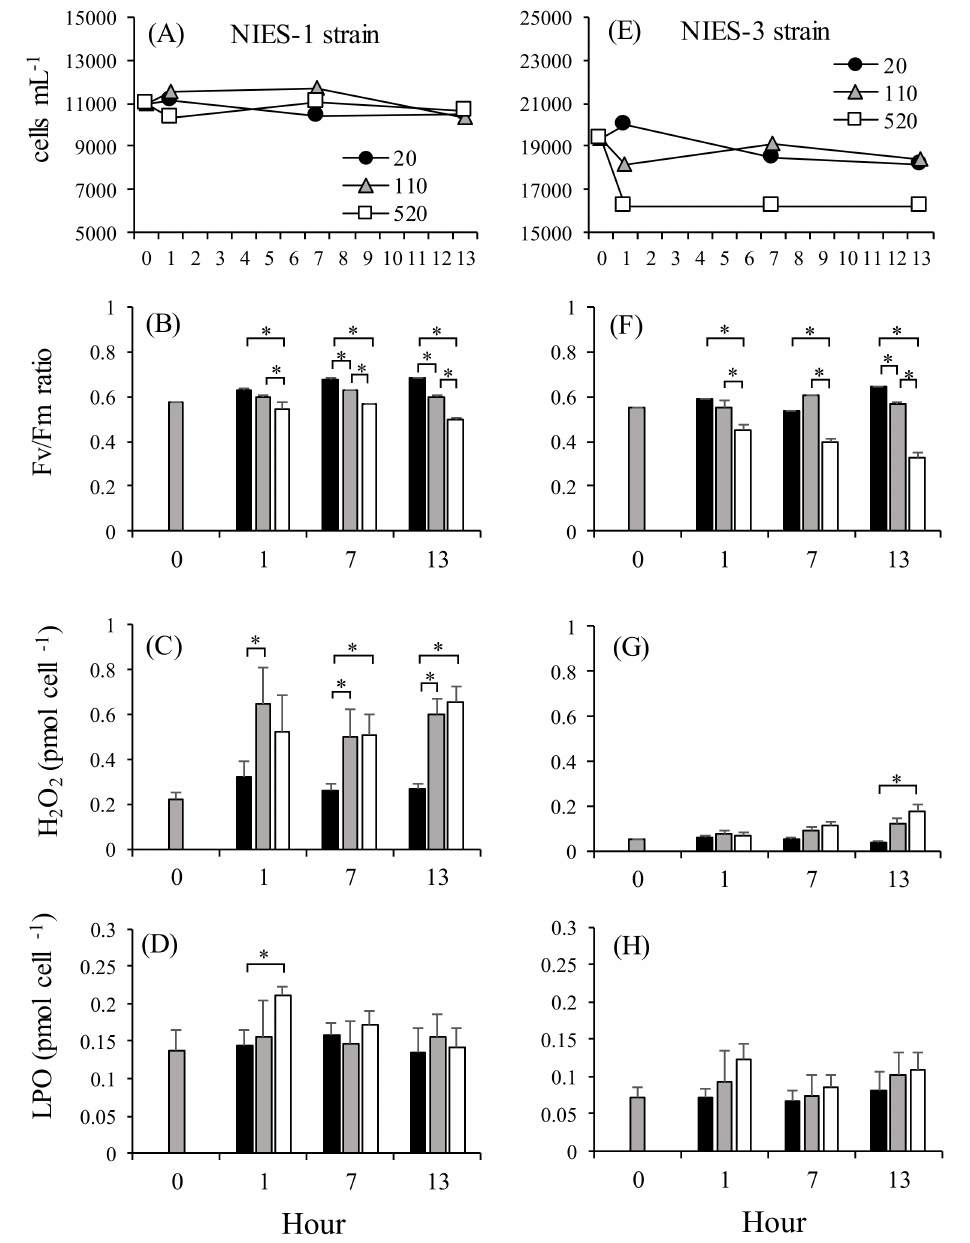
Figure 7. Change of cell densities, Fv/Fm ratios, H 2 O 2 concentrations, and lipid peroxide (LPO) concentrations in NIES-1 ( A – D ) and NIES-3 ( E – H ) strains during 13 h of exposure to different light intensities (20, 110, and 520 µ mol photons m − 2 s − 1 ). Values are means ± SDs (N = 4). Asterisks indicate significant differences in expression levels ( p < 0.05 by Tukey–Kramer and Scheffe’s F